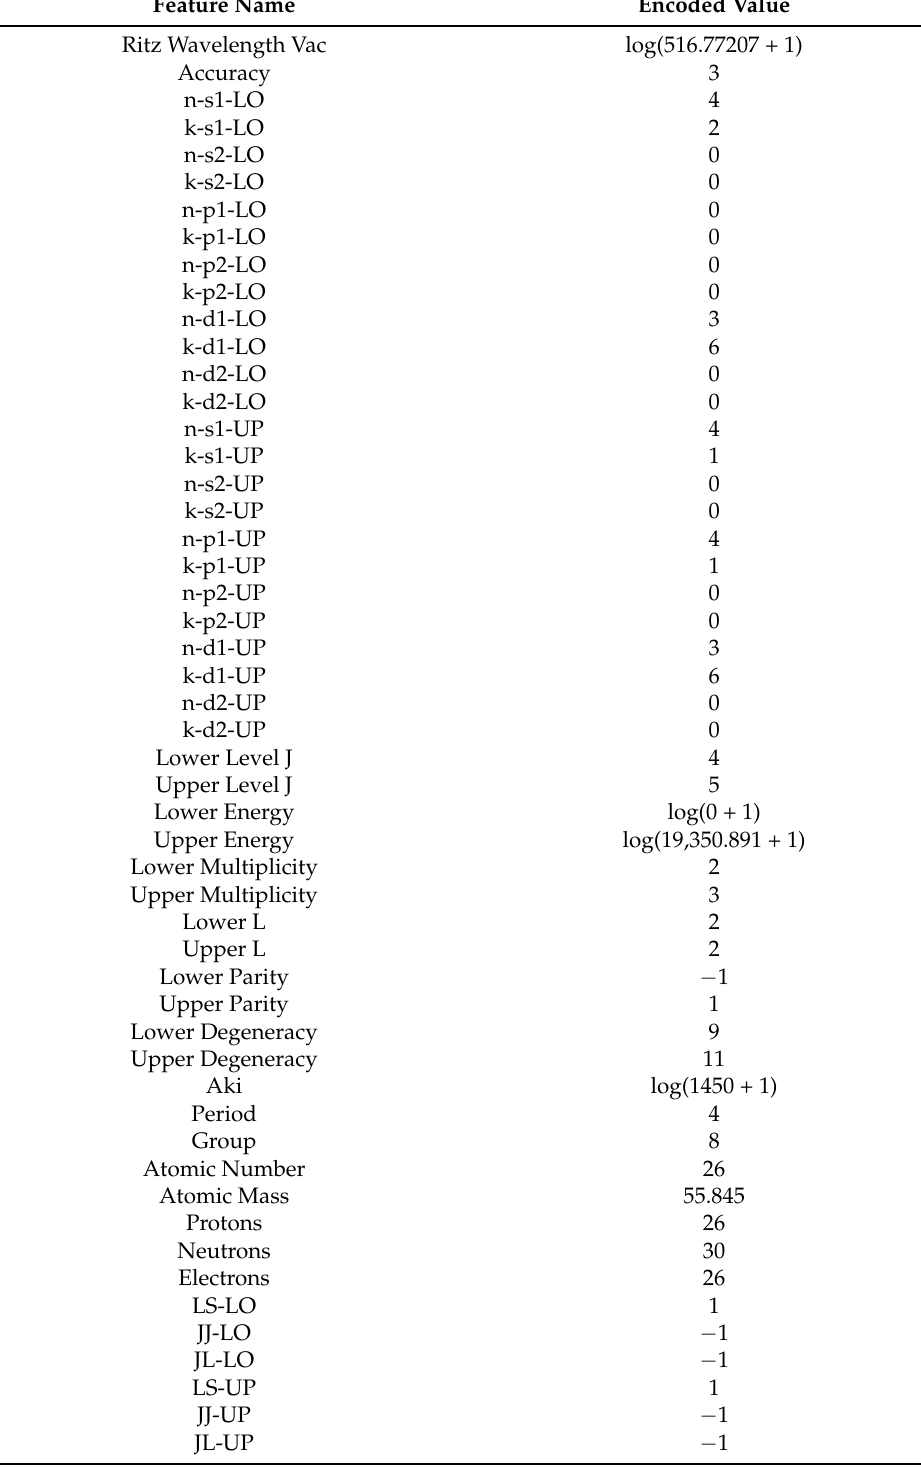
Table A2. Example feature vector representation for the transition of iron I from excited